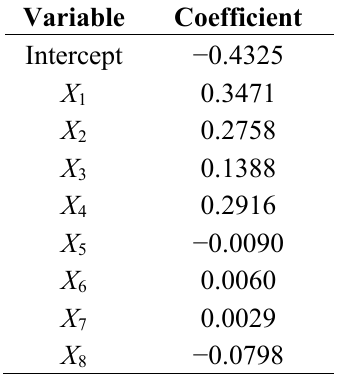
Table 3. Coefficient values for